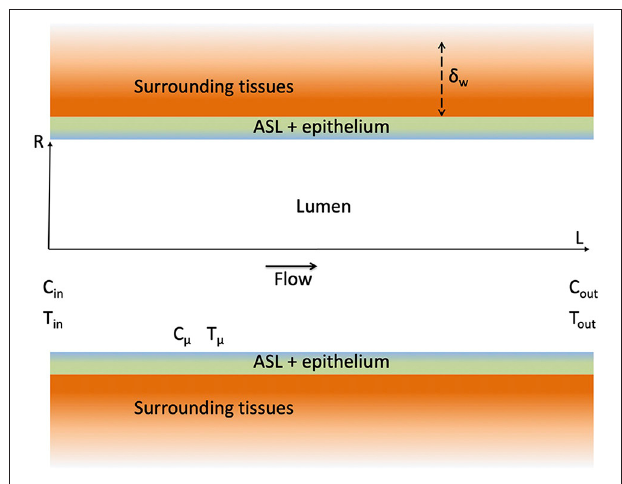
FIGURE 2 | Schematic representation of an airway and the surrounding tissues. The figure is not on